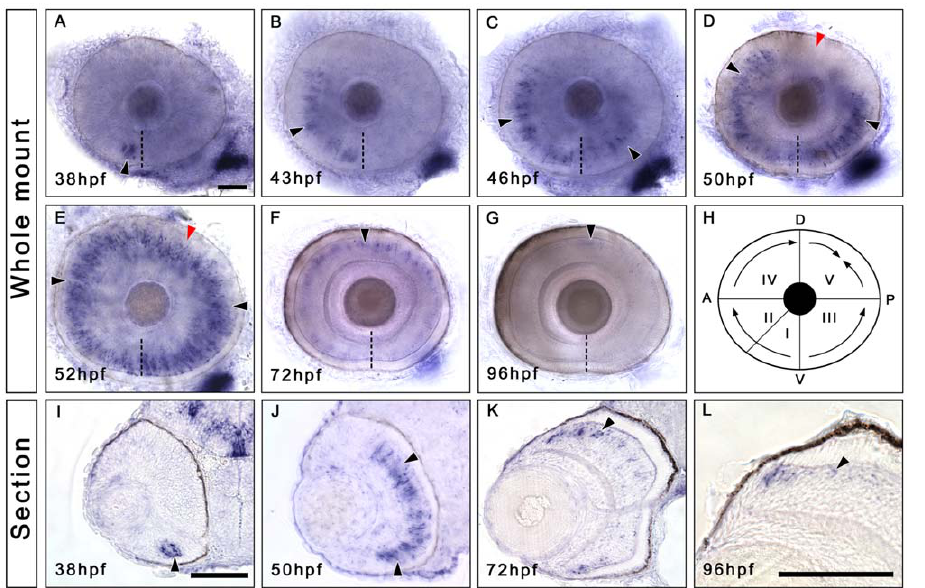
Figure 1. Irx7 is specifically expressed in the prospective INL during zebrafish retinal development. Whole-mount in situ hybridization was conducted to elucidate the expression dynamics of irx7 in embryonic retinas. (A–G) Dissected eyes obtained from embryos between 38 to 96 hpf. Anterior is to the left and dorsal is up. The black arrowheads indicate the irx7 + cells (blue colour) in the retina, the dashed lines indicate the choroid fissure, while the red arrowheads in (D and E) indicate the posterior dorsal region of the retina, the last region to express irx7 . (H) A schematic diagram of irx7 expression dynamics in the retina from 38 to 52 hpf. The Roman numerals indicate the order of five retinal regions in which irx7 appears sequentially. (I–L) Transverse retinal section of the corresponding whole-mount embryo at 38, 50, 72 and 96 hpf. Lateral is to the left and dorsal is up. The black arrowheads indicate the irx7 + cells in the retina. Scale bars=50 m m.